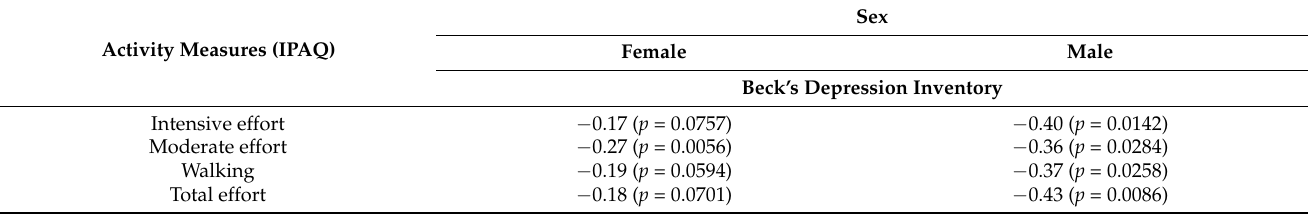
Table 4. The level of physical activity and the occurrence of depression—values of Spearman’s rank correlation coefficients.